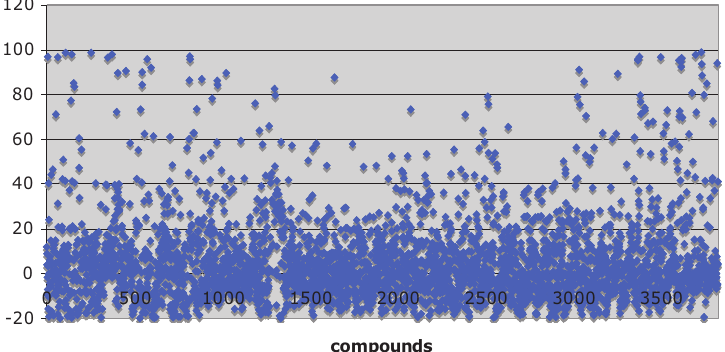
Figure 1. Scatter plot showing the activities of 3,859 of the compounds